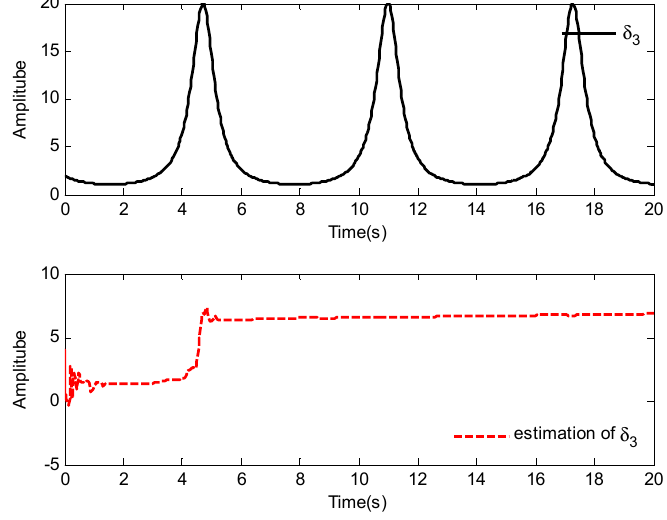
Figure 13. Response of δ 3 and ˆ δ 3 .